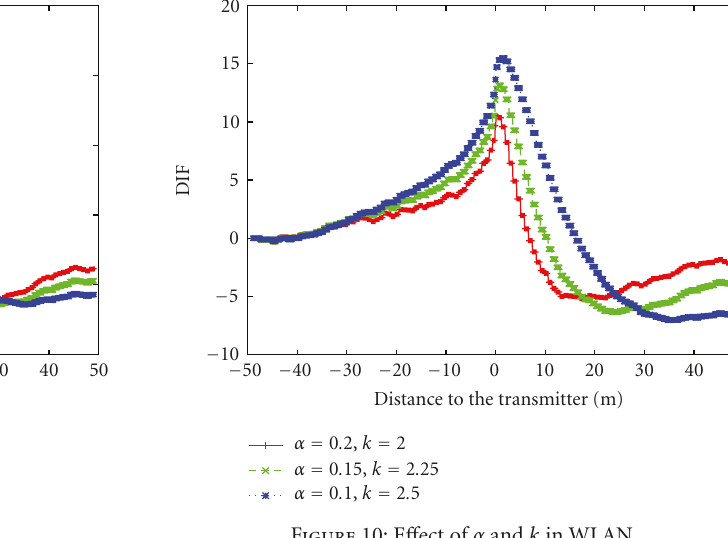
Figure 10: E ff ect of α and k in WLAN.